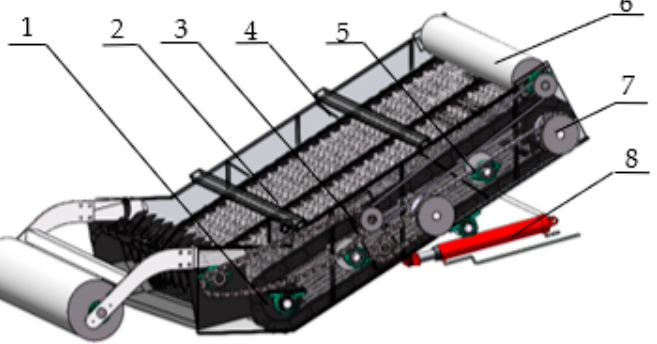
Figure 5. The hoisting devices. 1. Driven sprocket; 2. Vibrating screen; 3. Hoisting chain; 4. Vibrating drum; 5. Driving sprocket; 6. Soil roller; 7. Drive sprocket; 8. Hydraulic support cylinder.